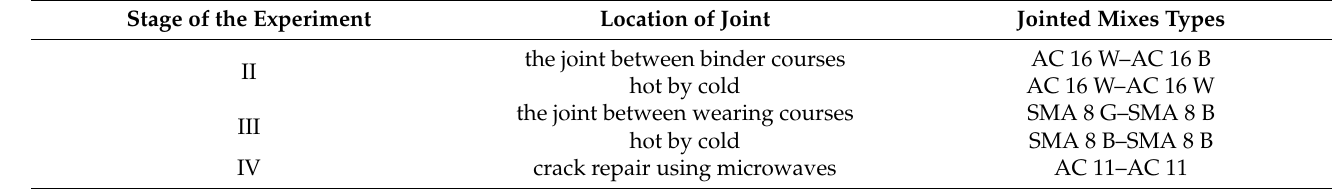
Table 4. Stages of experiment.